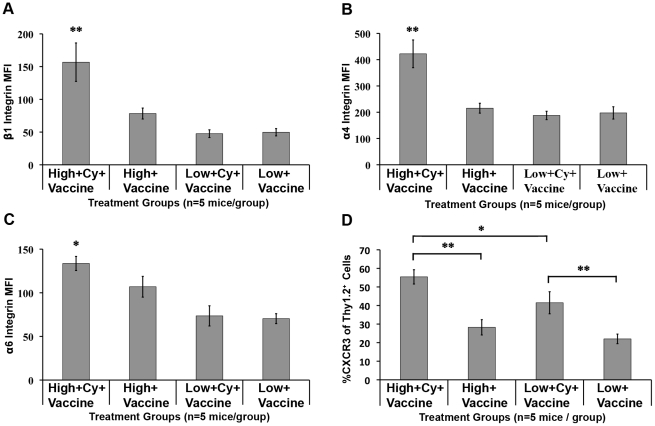
Cy plus vaccine enhances VLA-4, VLA-6, and CXCR3 expression on high avidity T cells.On day 3, TDN lymphocytes from neu-N mice were stained for (A) β1 integrin expression, (B) α4 integrin, or (C) α6 integrin, and the Mean Fluorescent Intensities (MFI) calculated. (n = 3mice/group). Isotype control MFIs were β1 integrin ∼20, α4 integrin ∼50–100, α6 integrin ∼30. (D) TDN lymphocytes from neu-N mice on day 5 were stained for CXCR3 and the %CXCR3+ of Thy1.2 cells was calculated (n = 5 mice/group). MFI isotype for CXCR3 is ∼10. * = p<0.05, ** = p<0.001. High/low = High or low avidity T cell transfer, respectively. Cy = Cyclophosphamide treatment. Vaccine = 3T3neuGM vaccine, Mock = 3T3GM control vaccine. Each experiment was repeated three times with similar results.